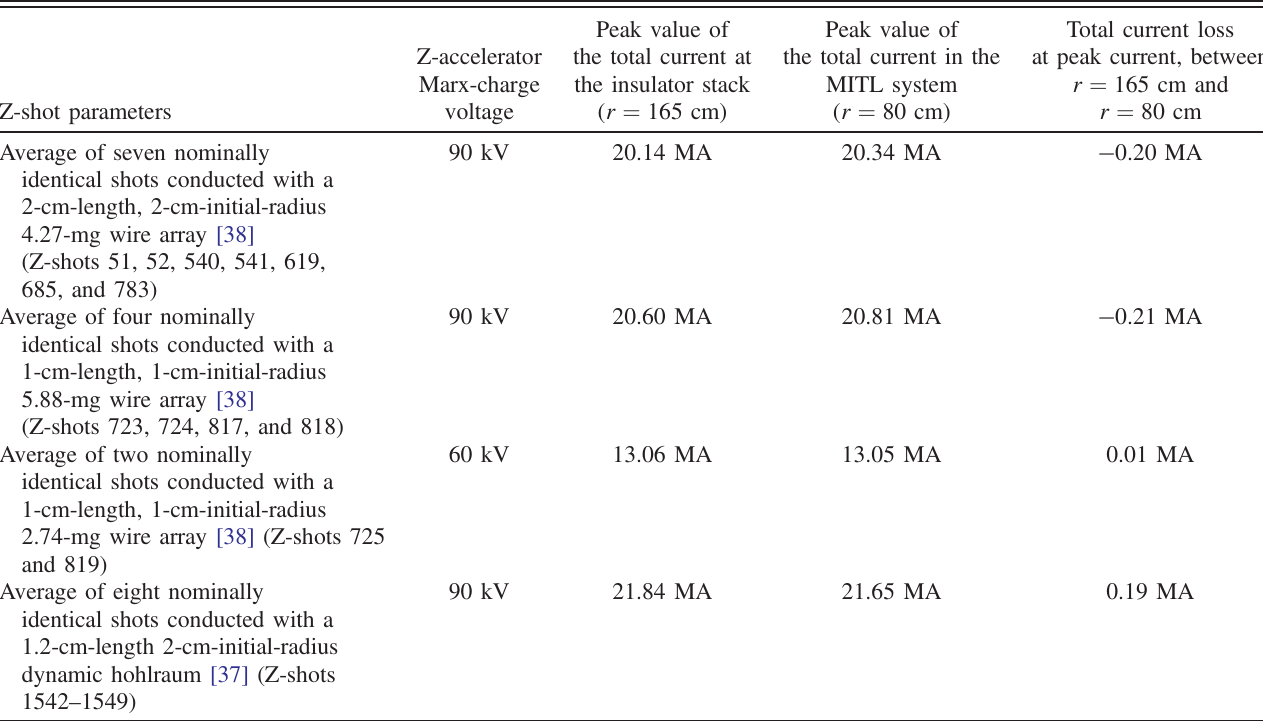
TABLE II. Measured insulator-stack, MITL, and loss currents for several sets of shots conducted on the Z accelerator. The shots are described in Refs. [37,38]. The measured loss includes that due to insulator flashover at the insulator stacks, MITL-injection current loss between the vacuum flares and outer MITLs, electron-leakage current in the outer MITLs, positive-ion emission from the outer-MITL anodes, and negative-ion emission from the outer-MITL cathodes. For the 90-kV shots, the estimated uncertainty ( 1 σ ) in the current loss is 0.4 MA; for the 60-kV shots, the uncertainty is 0.26 MA. Hence for each of the four sets of measurements summarized here, the measured current loss between r ¼ 165 cm and r ¼ 80 cm is less than the measurement